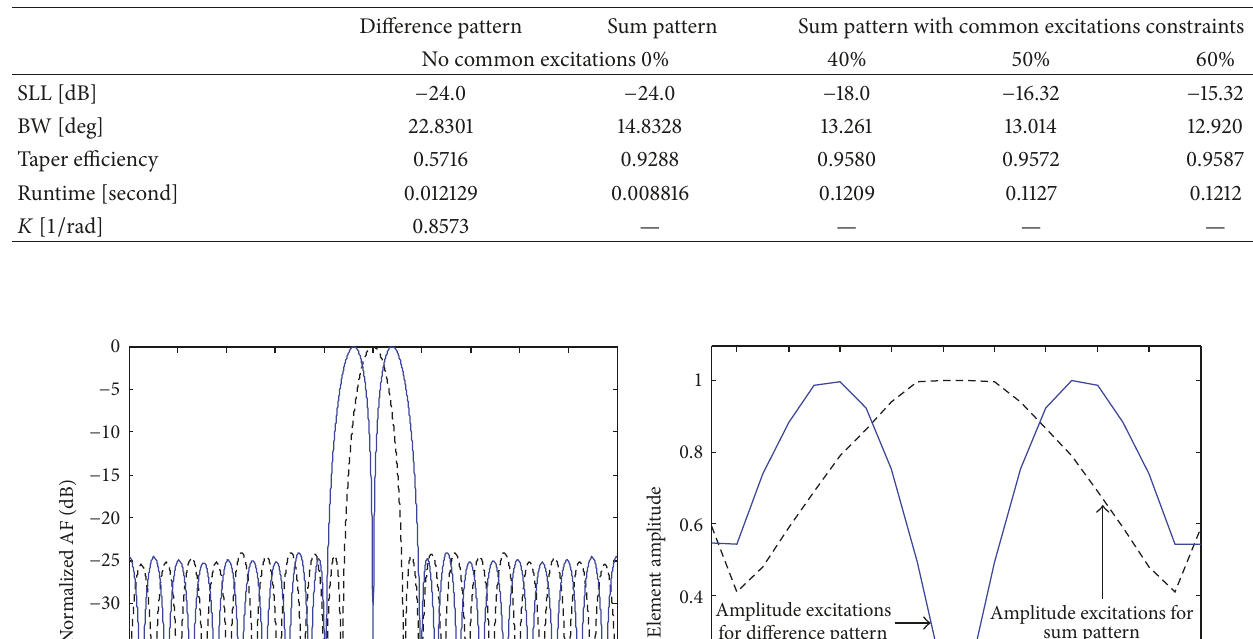
Table 1: Patterns features when 𝑁 = 20 and 𝑑 = 𝜆/2 and different percentage of sharing excitations.